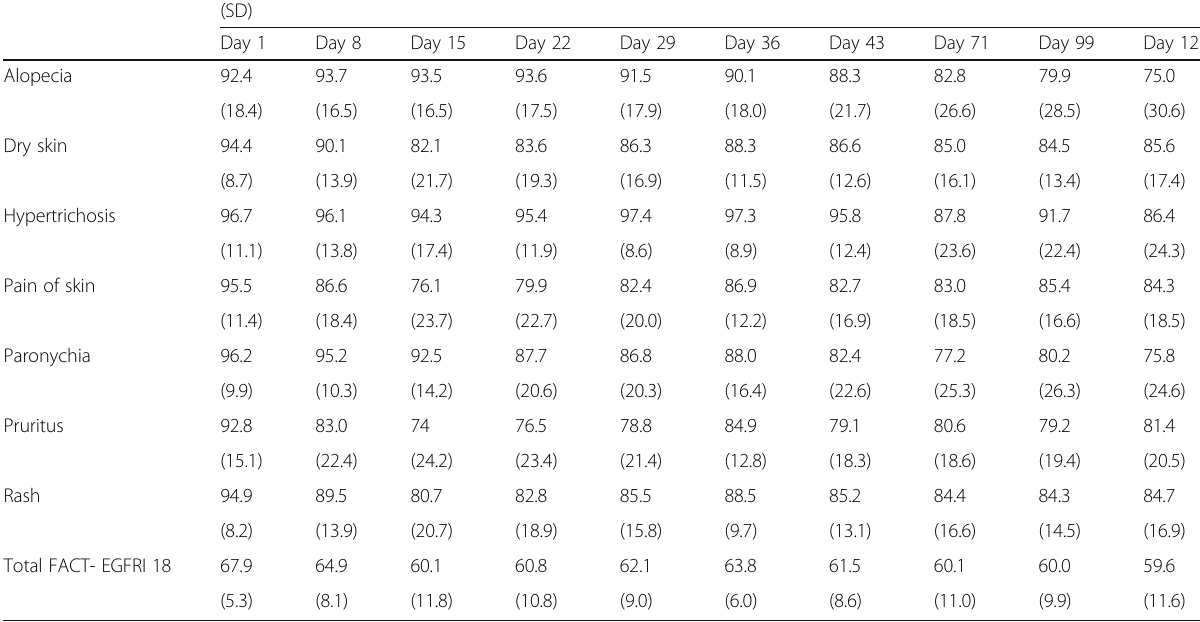
Table 2 Descriptive Statistics for Total FACT-EGFRI 18 Scale and Subscale